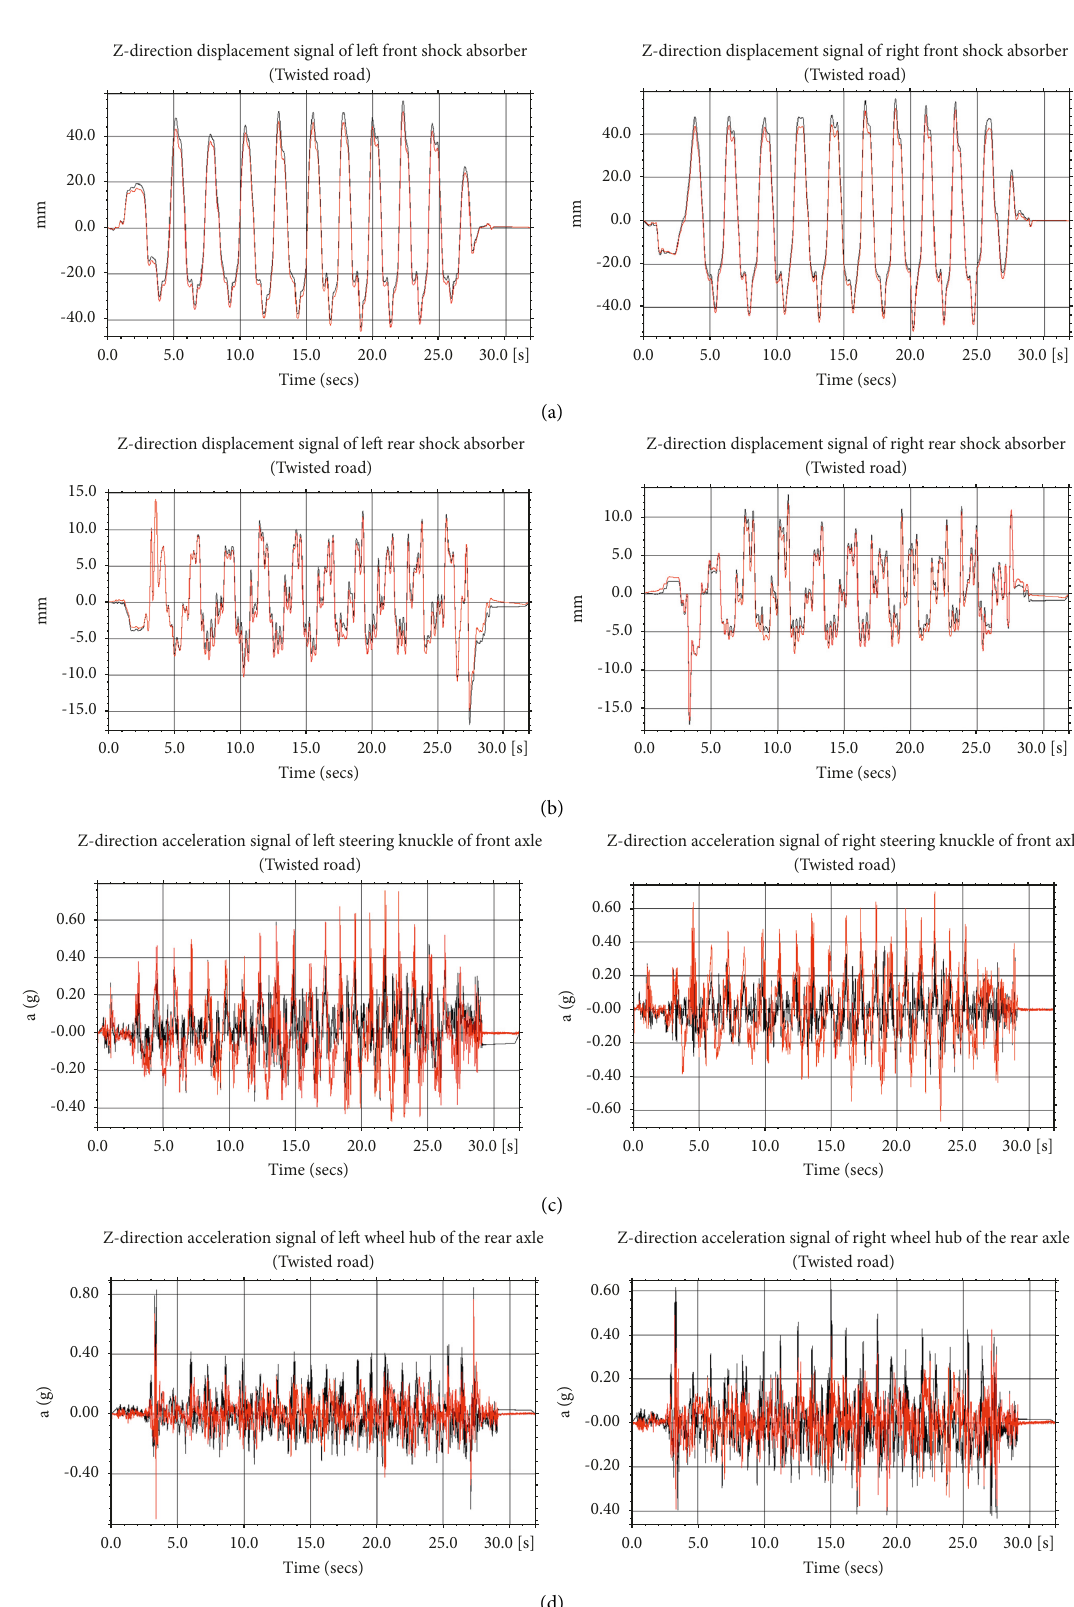
Figure 8: Comparison diagrams between the iterative signals and the measured signals (twisted road). (a) Left and right front shock absorbers displacement signals. (b) Left and right rear shock absorbers displacement signals. (c) Steering knuckle acceleration signals on both sides of the front axle. (d) Wheel hub acceleration signals on both sides of the rear